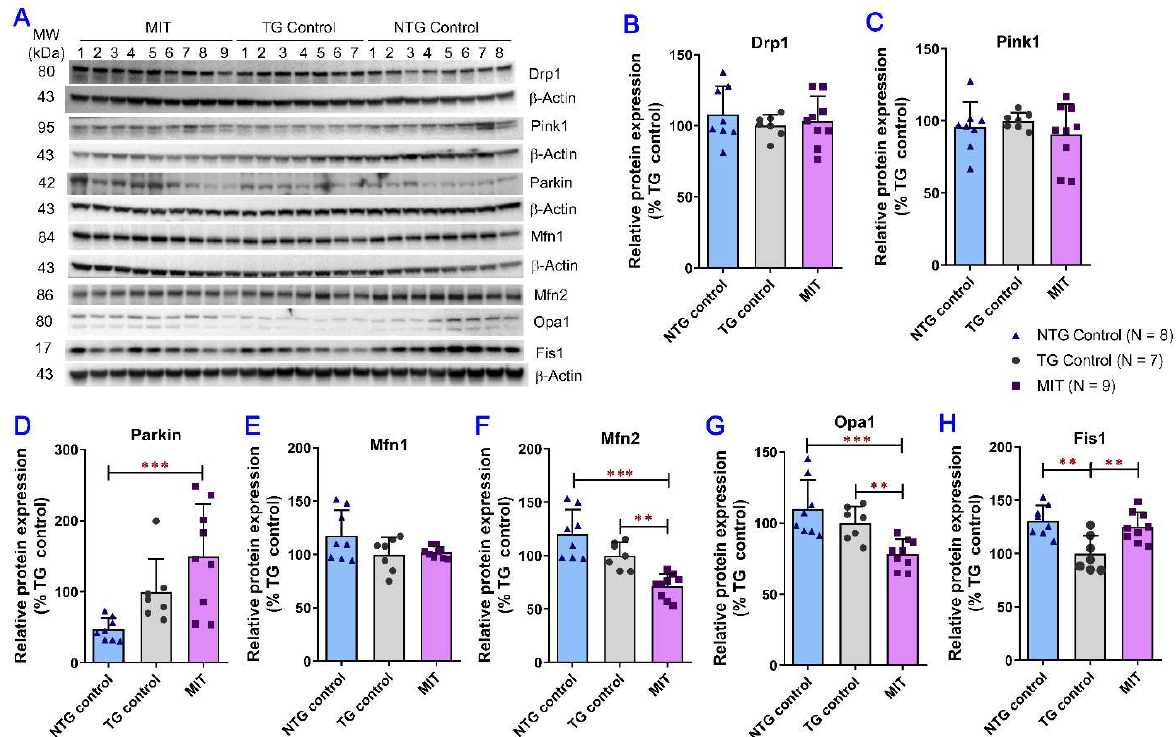
Figure 5. Evaluation of the MIT effect on mitochondrial fission/fusion events and mitophagy in the brain using the semi-quantitative Western blot analysis. The brain tissue samples were collected from the TG and NTG vehicle-treated control mice and the MIT-treated TG mice after the 3-month intranasal treatment. ( A ) Representative immunoblots showing the expression of Drp1, Pink1, Parkin, Mfn1, Mfn2, Opa1 and Fis1 in brain tissues collected from individual mice. Densitometric analysis of the relative expression of ( B ) Drp1, ( C ) Pink1, ( D ) Parkin, ( E ) Mfn1, ( F ) Mfn2, ( G ) Opa1, and ( H ) Fis1 proteins in brain tissues obtained from different study groups. The mean expression levels of Mfn2, Opa1, and Fis1 proteins in the brain tissues of MIT-treated APP/PS1 mice were significantly lower than those in the TG control mice ( p < 0.01 for all). The data are expressed as mean ± SD (N = 8 for the NTG control group, N = 7 for the TG control group, and N = 9 for the TG MIT treatment group). SD is denoted by error bars. ** p < 0.01, and *** p < 0.001 were compared between the NTG